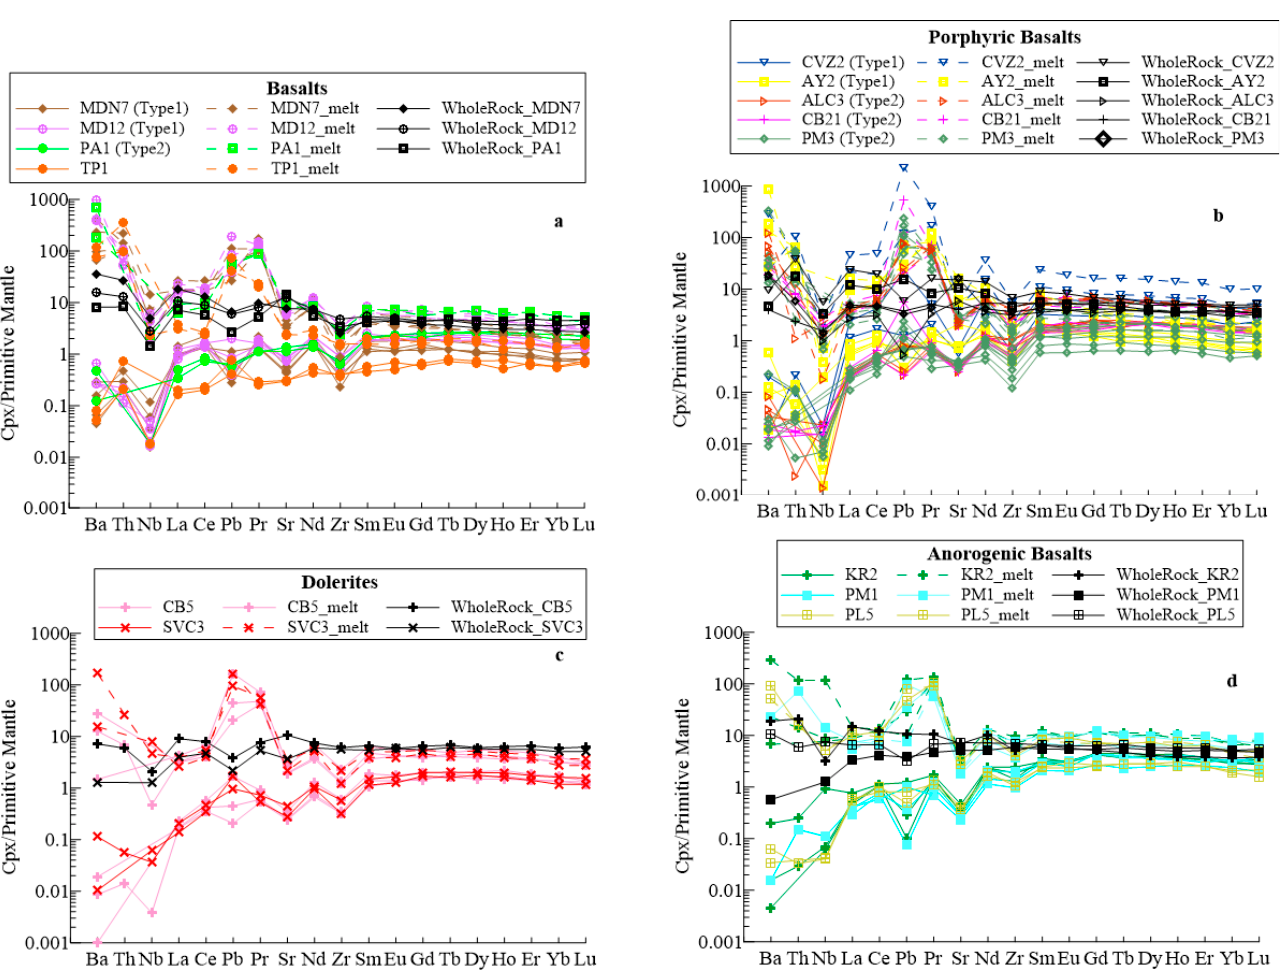
Figure 10. Calculated multi-element variation patterns of the parental melt in equilibrium with clinopyroxene phenocrysts from the Yüksekova Complex. ( a ) Basalts; ( b ) Porphyric basalts; ( c ) Dolerites; ( d ) Anorogenic basalts.